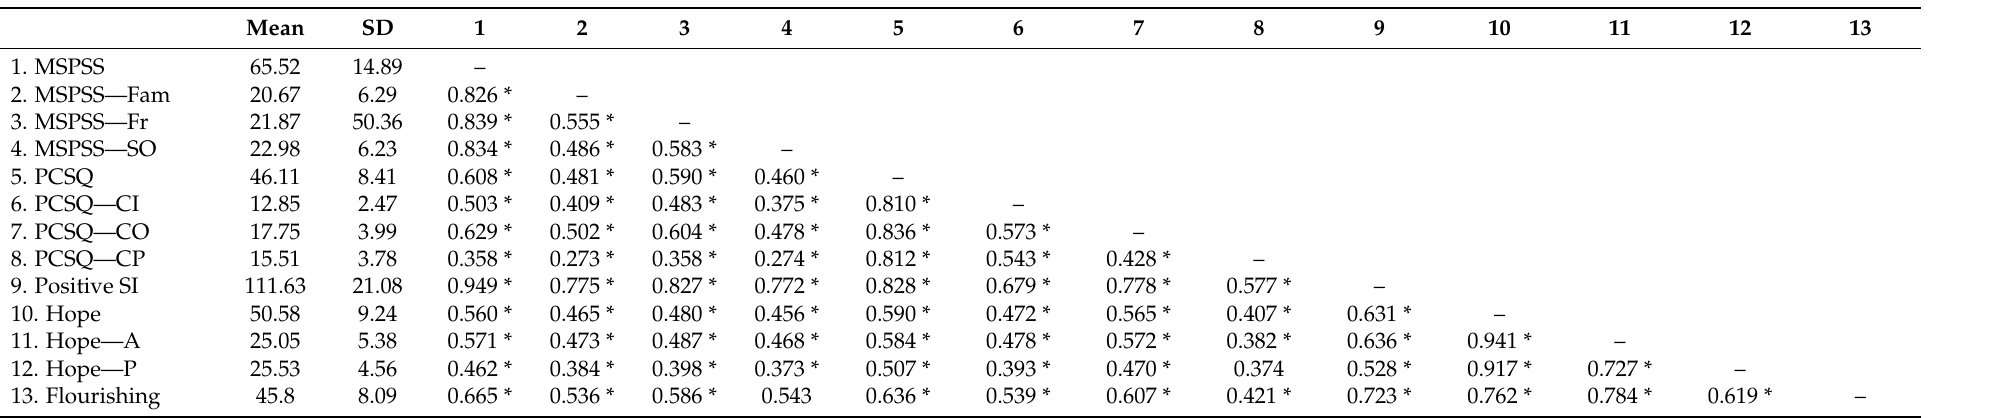
Table 2. Means, standard deviations, and bivariate